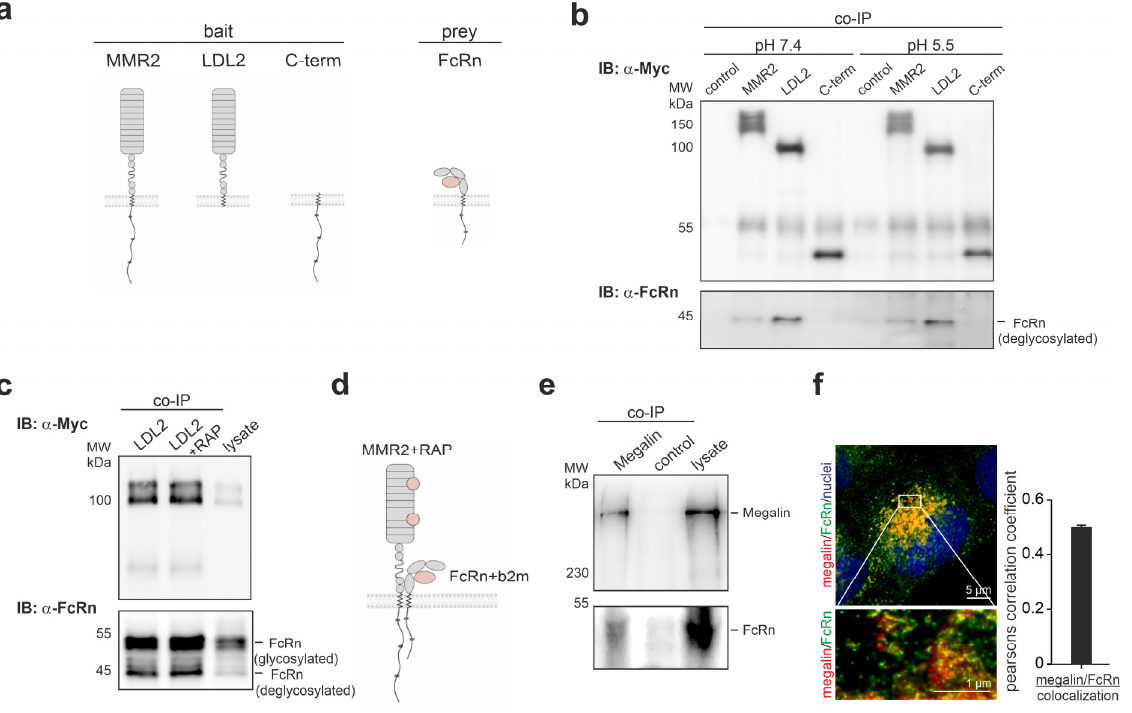
Figure 2. FcRn binds to the extracellular domain of megalin outside of the ligand-binding domain. ( a ) Cartoon of truncated megalin domains (MMR2–megalin mini receptor 2; LDL2–extracellular domain of MMR2 without C-terminal domain; C-term–C-terminal domain of megalin) and FcRn used for co-im- munoprecipitation. ( b ) Co-immunoprecipitation (Co-IP) of truncated megalin domains and FcRn, using